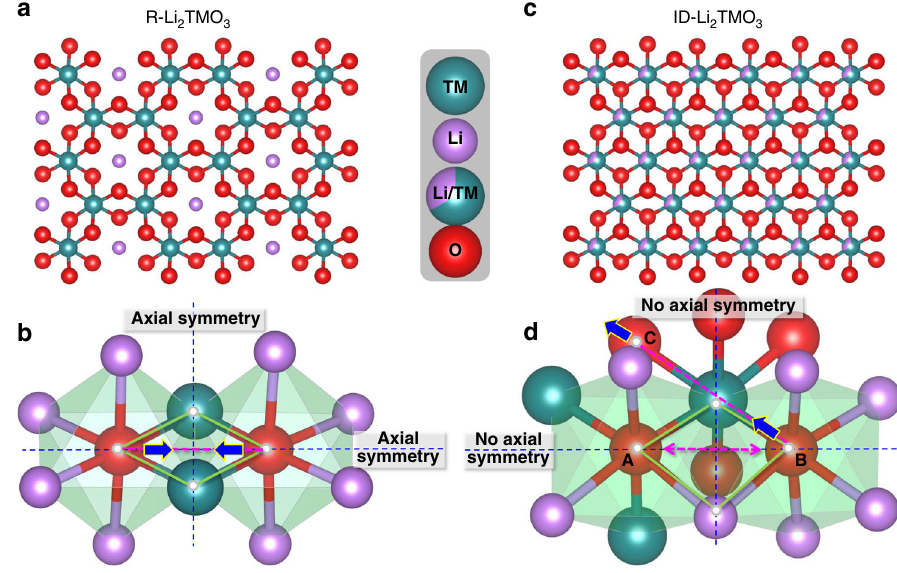
Fig. 1 Layered structures and structural response modes. a , b Crystal structure ( a ) and structural response mode ( b ) of R-Li 2 TMO 3 to the oxygen redox reaction. c , d Crystal structure ( c ) and of structural response mode ( d ) of ID-Li 2 TMO 3 to the oxygen redox reaction during